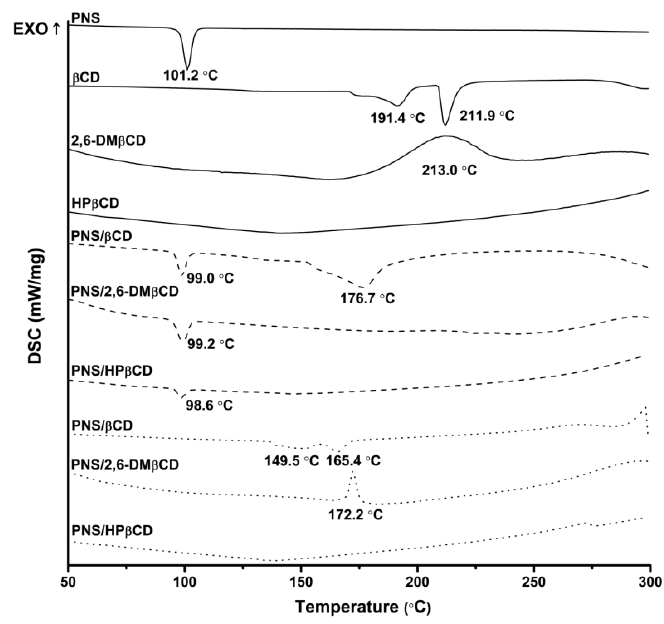
Figure 3. Differential scanning calorimetry (DSC) thermogram of free compounds (—) and PNS/βCDs inclusion complexes prepared by physical mixture ( ) and freeze-drying method (···).